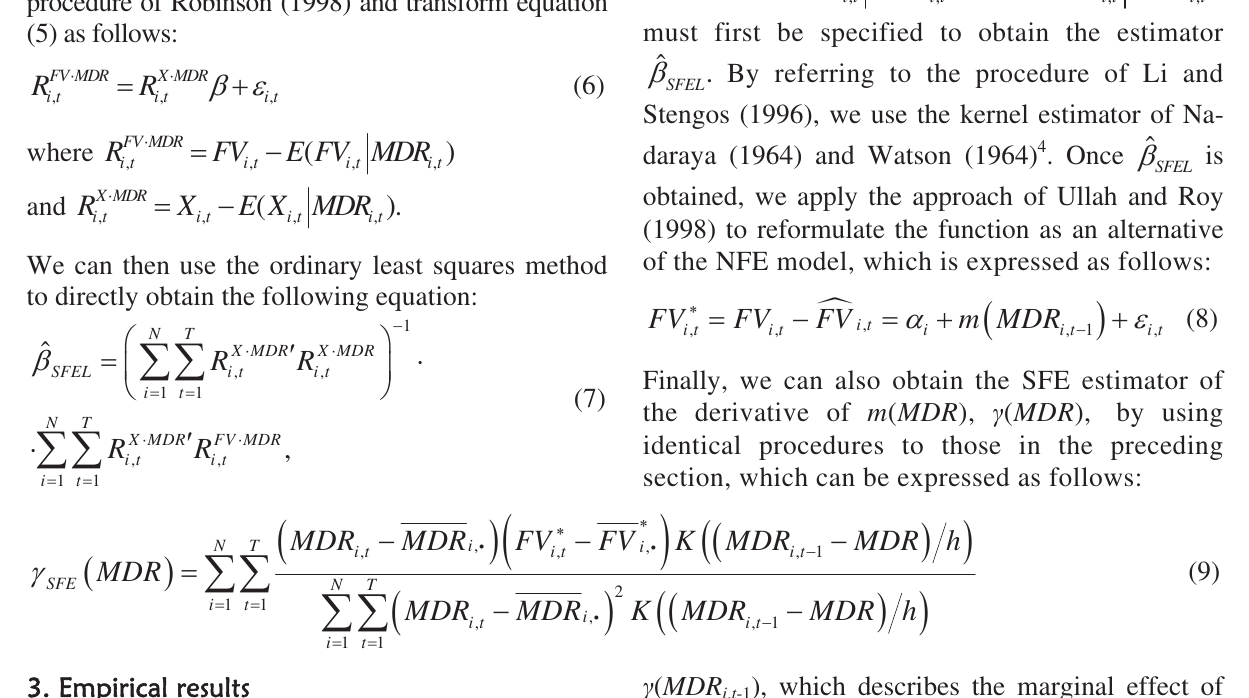
Figure 2. Notably, the solid line for each point on the X-axis represents the individual marginal effect of the MDR . For example, when the MDR is 0.1 (on the X-axis), the derivative of m ( MDR